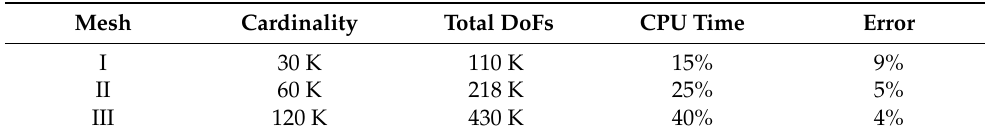
Table 2. Mesh independence test. Approximate number of triangular elements and of degrees of freedom, relative computational time, and relative error with respect to a fine mesh